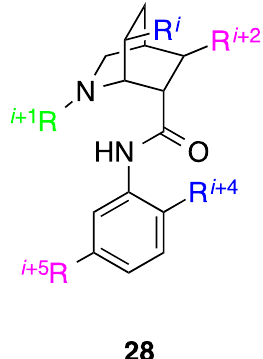
Figure 12. A novel helix mimetic that projects functionality in a similar orientation to five of seven residues spanning two turns of an